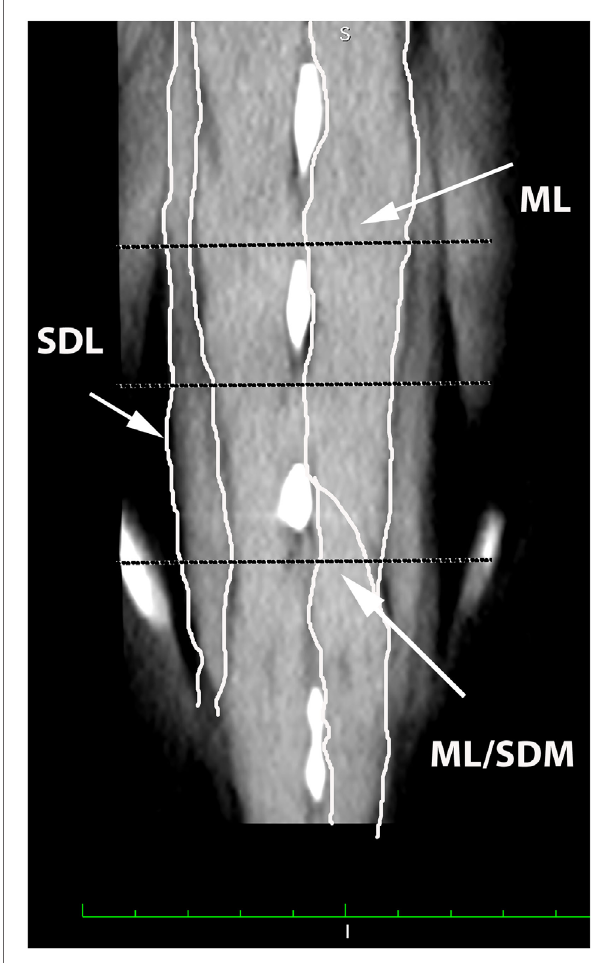
FIGURe 2 | dorsal oblique multiplanar Ct image at the level of the L5–s1 spinous processes, illustrating margins of the multifidus lumborum (ML), sacrocaudalis dorsalis lateralis (sdL), and sacrocaudalis dorsalis medialis (sdM) . Cranial is at the top of the image and the patient’s right is on the viewer’s left. Transverse dotted lines illustrate the locations of L5–6, L6–7, and L7–S1.